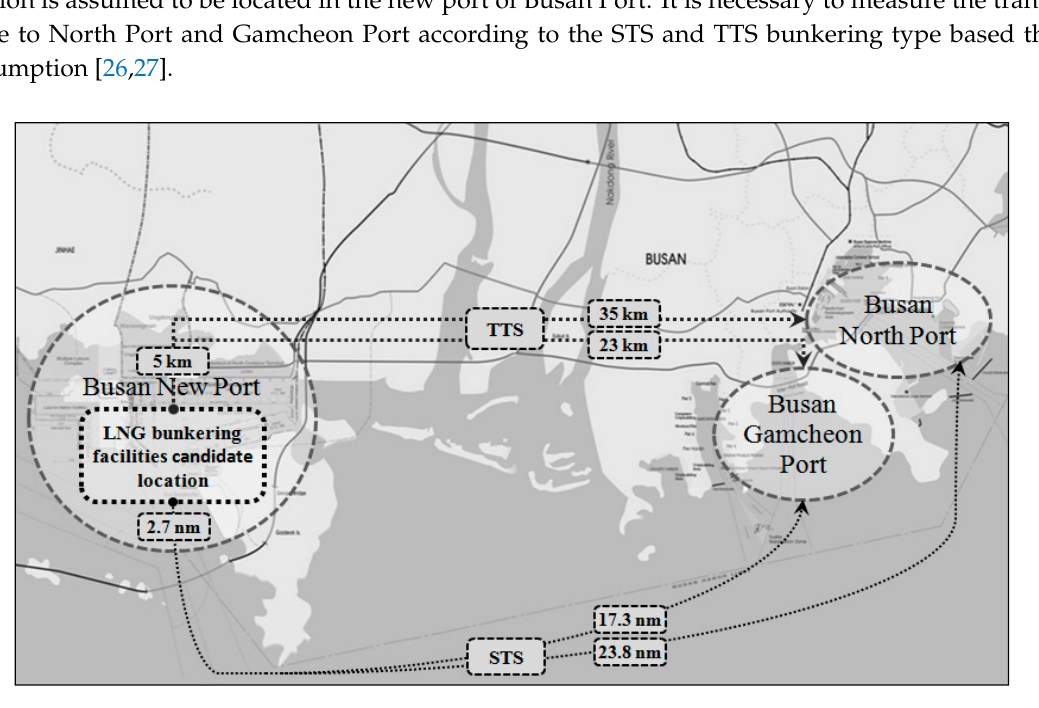
Table 9. Transit Time by TTS in Busan Port.